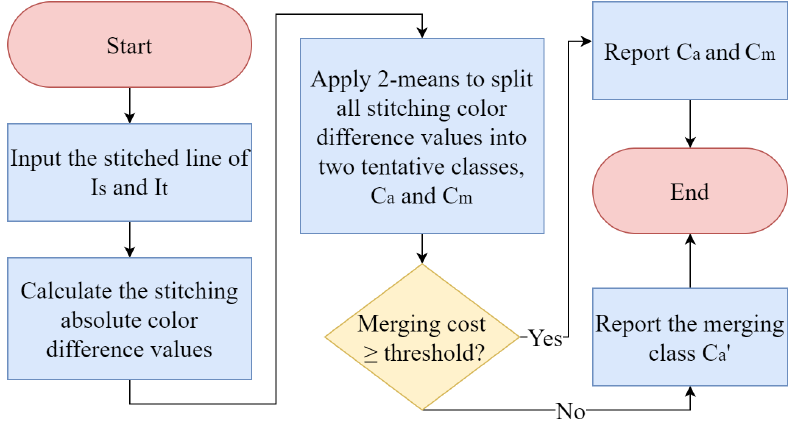
Figure 3. The flowchart of the proposed split-and-merge approach.